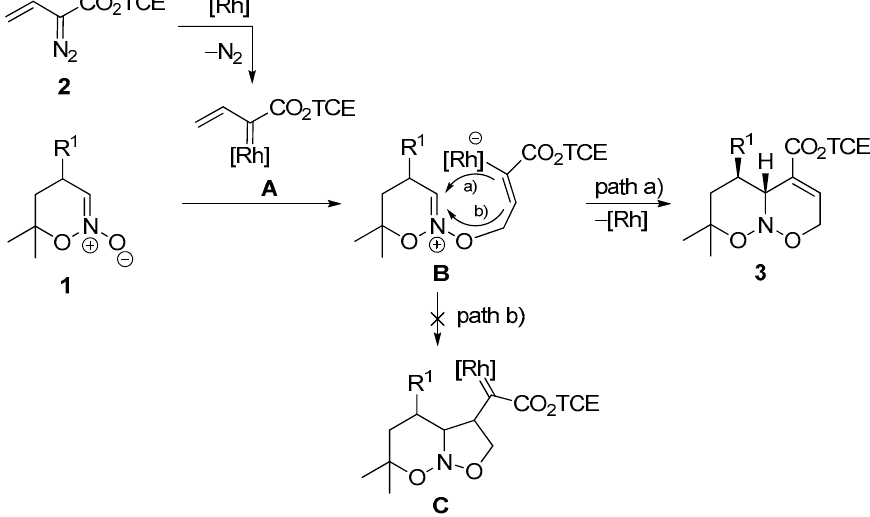
Figure 1. General view of the compounds 3b (left) and 3p (right) in the representation of non-hydrogen atoms as thermal ellipsoids at a 30% probability